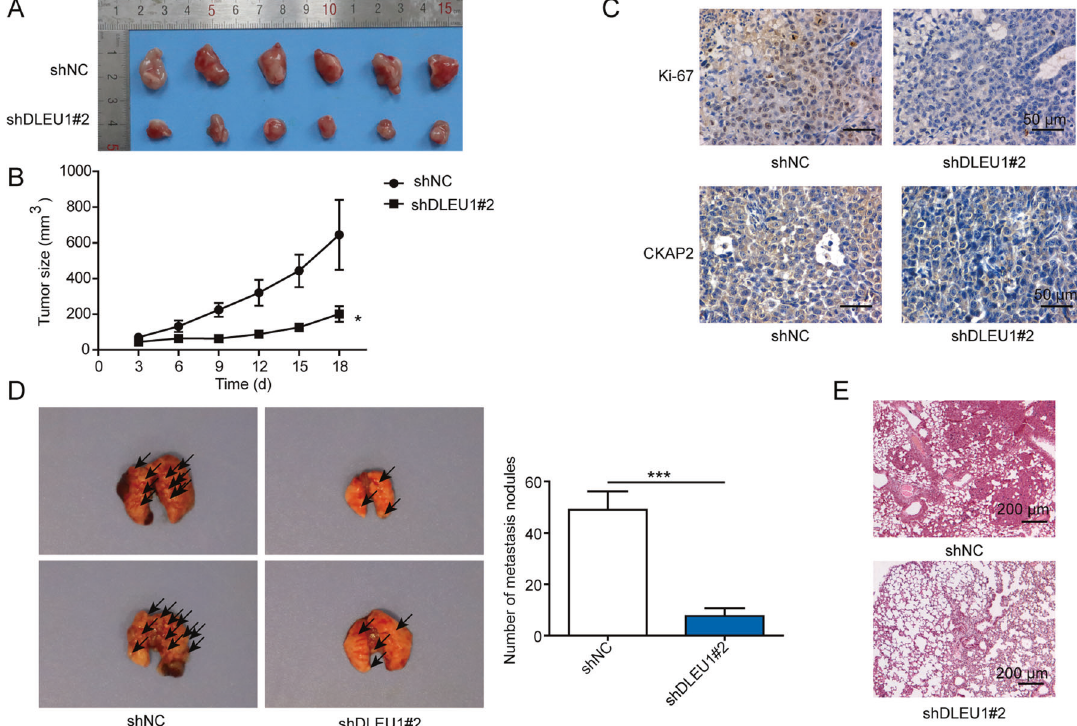
Fig. 7 Targeting DLEU1 inhibited in vivo xenograft growth and metastasis. shNC or shDLEU1#2 cells were subcutaneously injected into nude mice ( n = 6/group). A Pictures of xenografts isolated on day 18 from indicated groups. B Growth curve of xenografts in vivo. C Expressions of Ki-67 and CKAP2 were examined by immunohistochemistry from indicated xenografts. shNC or shDLEU1#2 cells were intravenously injected into nude mice ( n = 6/group). D Pictures of lungs isolated on day 28 from indicated groups were shown on the left, and macroscopic metastatic nodules quanti fi ed on the right. E HE staining of metastatic lung tissues. * P < 0.05, *** P < 0.001. Cell Death and Disease (2022)